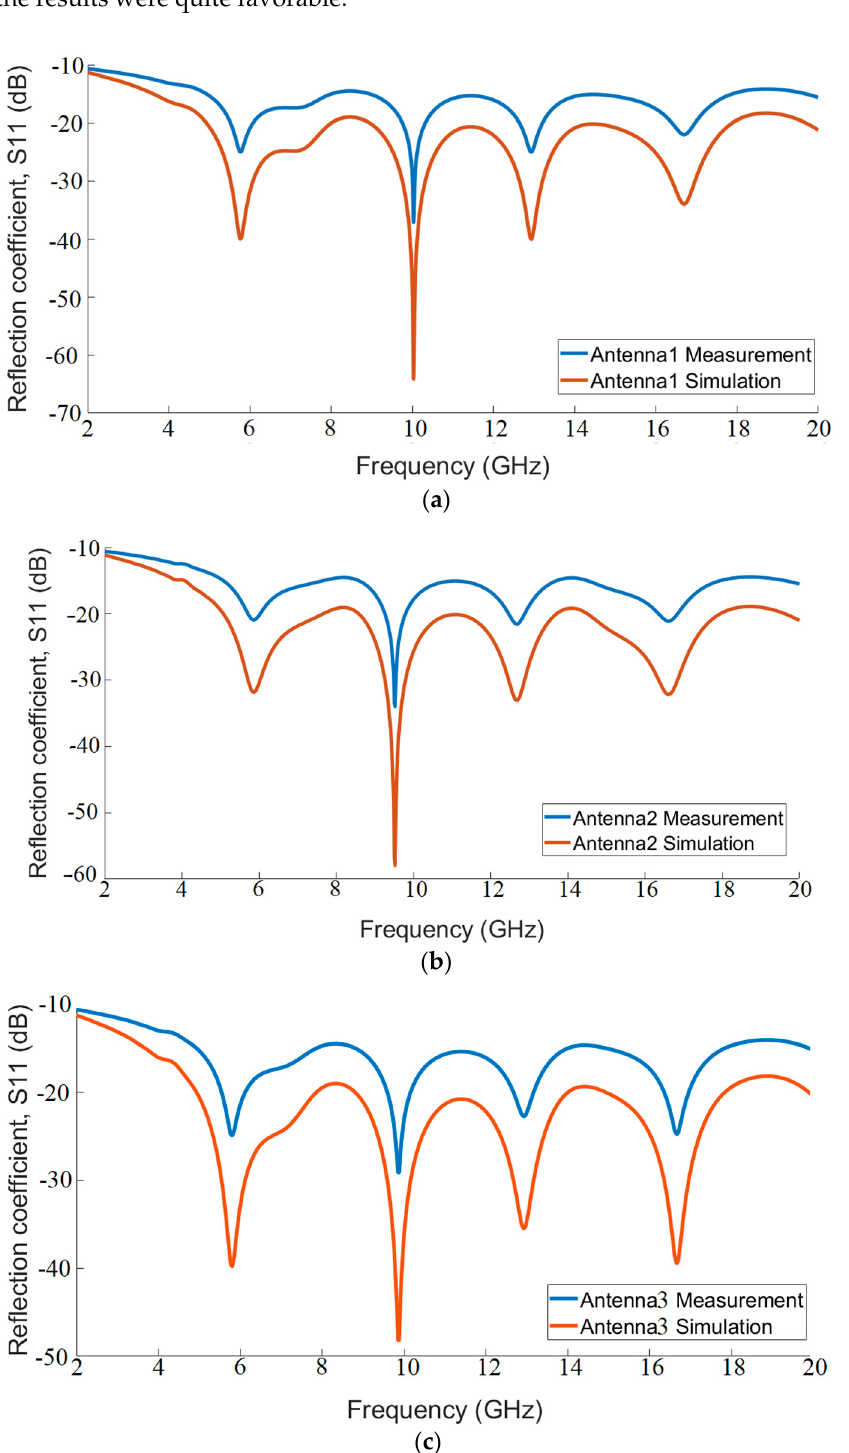
Figure 10. Reflection coefficients of ( a ) Antenna-1, ( b ) Antenna-2, and ( c ) Antenna-3 for bandwidth performance.